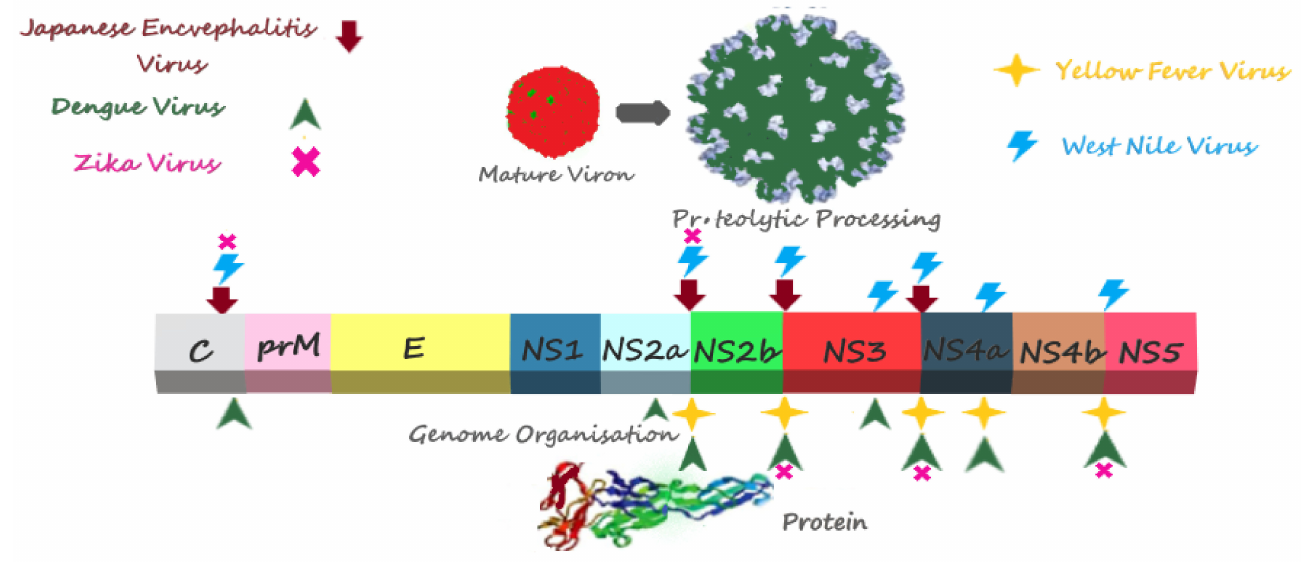
Figure 3. Cleavage sites proteolytically processed by NS2B-NS3 proteases in polyproteins of various flaviviruses: Cleavage sites proteolytically processed by Japanese encephalitis virus NS2B-NS3 pro- teases are shown by red arrows [32]; West Nile virus NS2B-NS3 cleavage sites are shown by blue lightning [67,118,122,123]; Yellow fever virus NS2B-NS3 cleavage sites are shown by yellow stars [69,70,124]; Dengue virus NS2B-NS3 cleavage sites are shown by green arrows [70,76,79,82,92,125,126]; and Zika virus NS2B-NS3 cleavage sites are shown by pink Xs